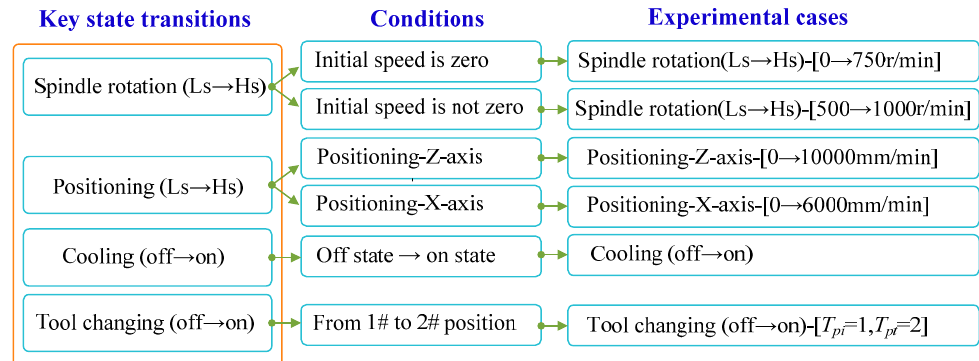
Figure 11. Determining process of experimental cases.